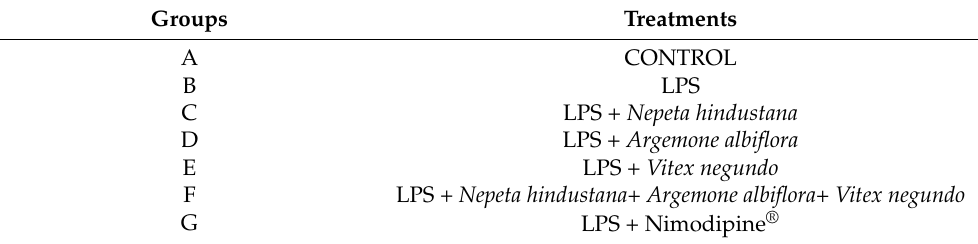
Table 1. Experimental design for disease induction and treatment protocol. Groups Treatments A